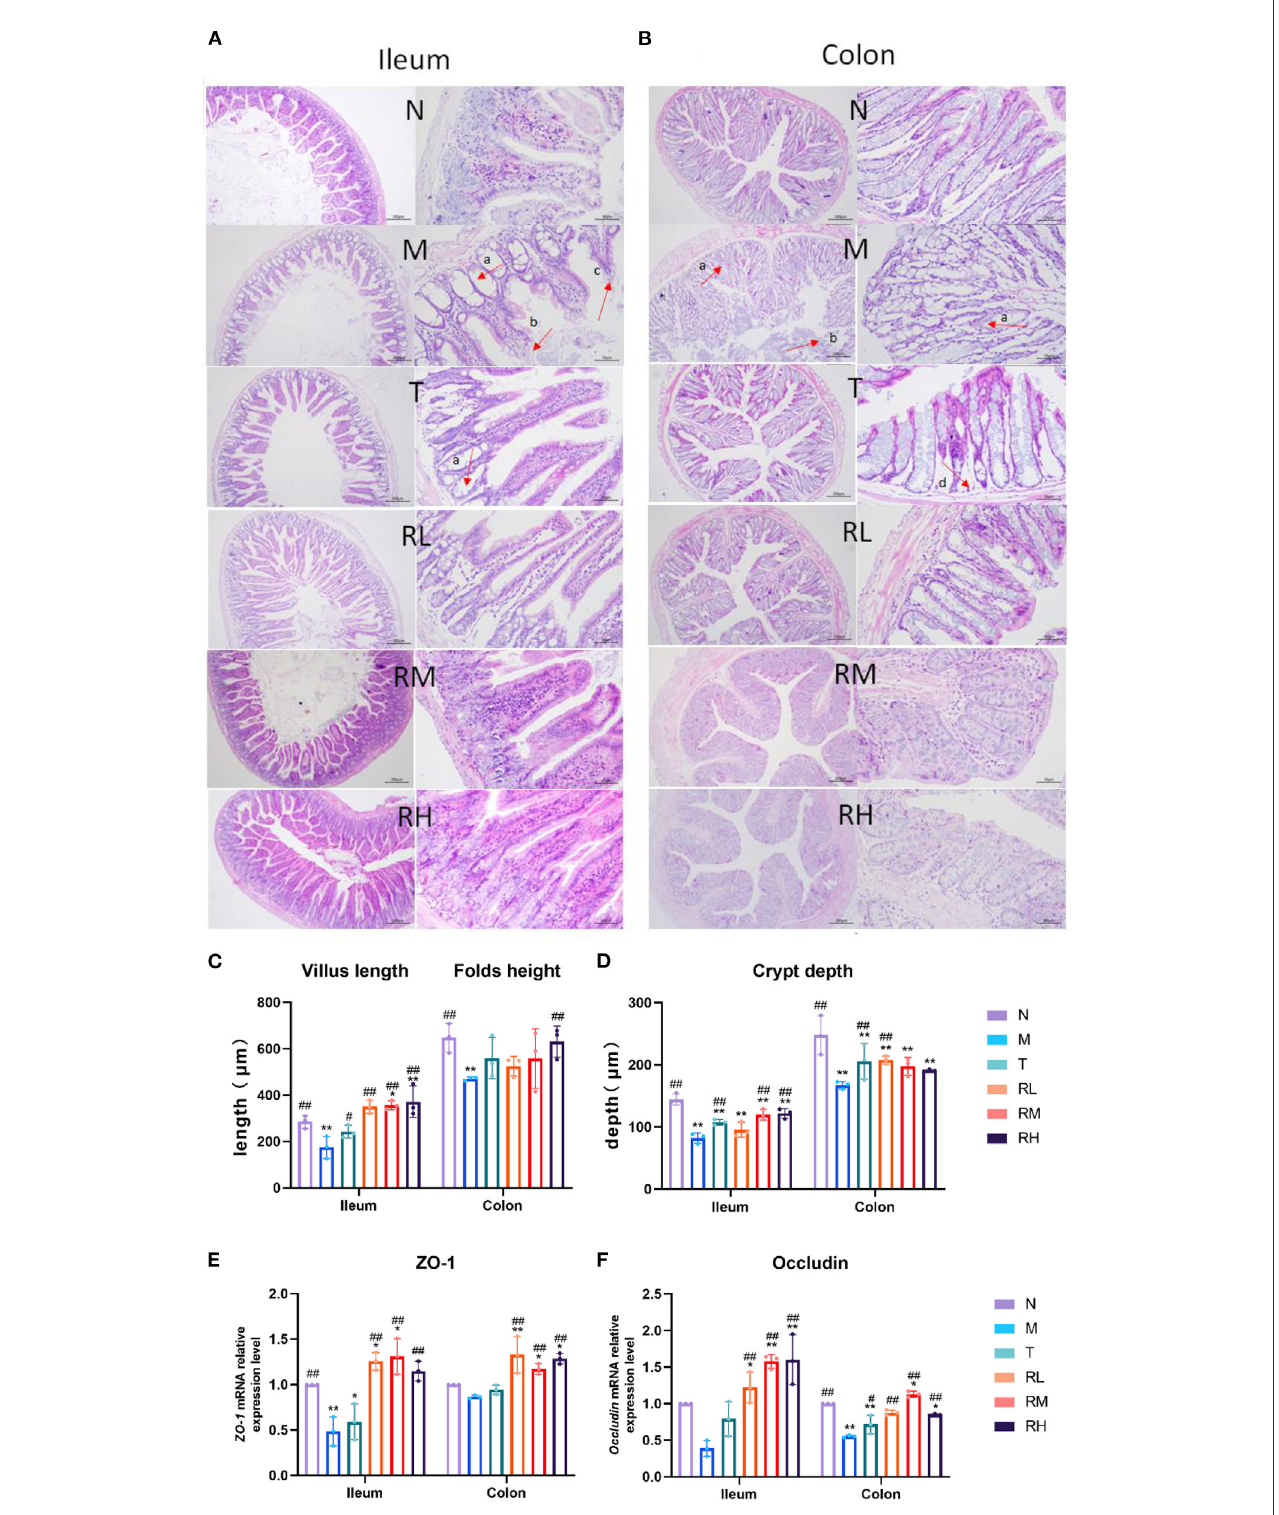
FIGURE3 Effect of RGO on intestinal epithelial barrier in LPS mice. (A) Pathological assessment of H&E-stained mice ileum sections; magnification 10 × and 40 × . (B) Pathological assessment of H&E-stained mice colon sections; magnification 10 × and 40 × . (C) Villus length and folds height. (D) Crypt depth. (E) ZO-1 mRNA relative expression level. (F) Occludin mRNA relative expression level (a. Intestinal gland necrosis; b. Epithelial cell exfoliation; c. The villus becomes shorter; d. Necrosis of intestinal gland basal layer). Compared with group N: * P < 0.05, ** P < 0.01; compared with group M. # P < 0.05, ## P <